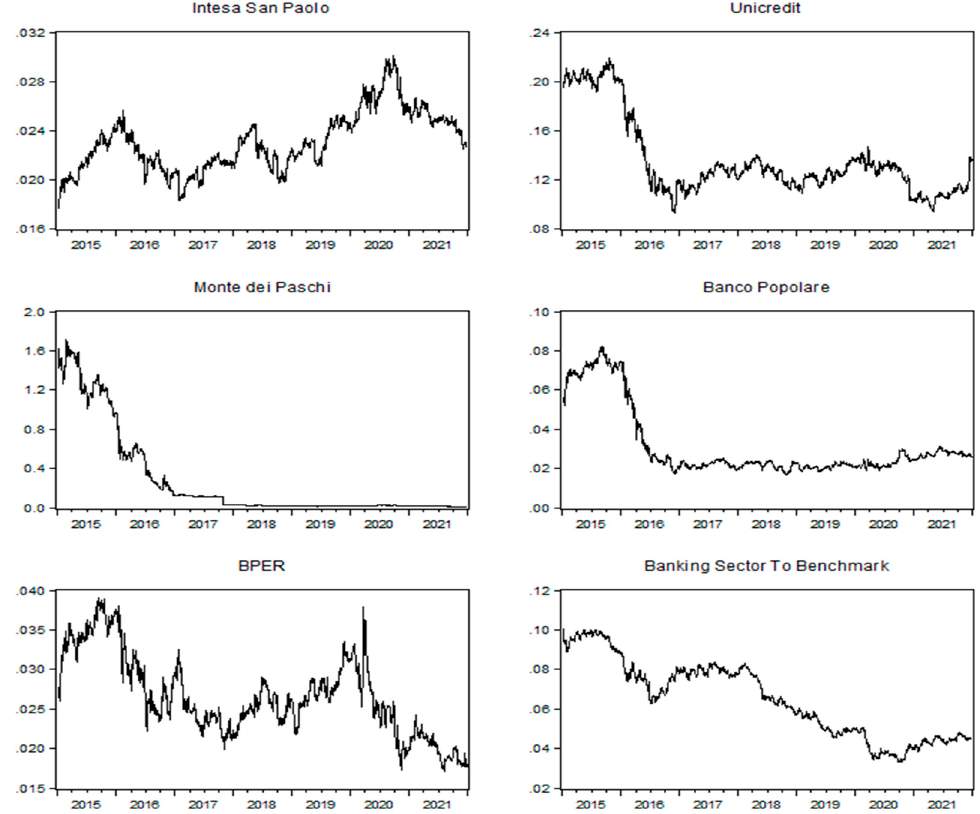
Figure 2. Relative strengths: January 2015 to December 2021. Source: authors’calculation in Eviews on Bloomberg data.